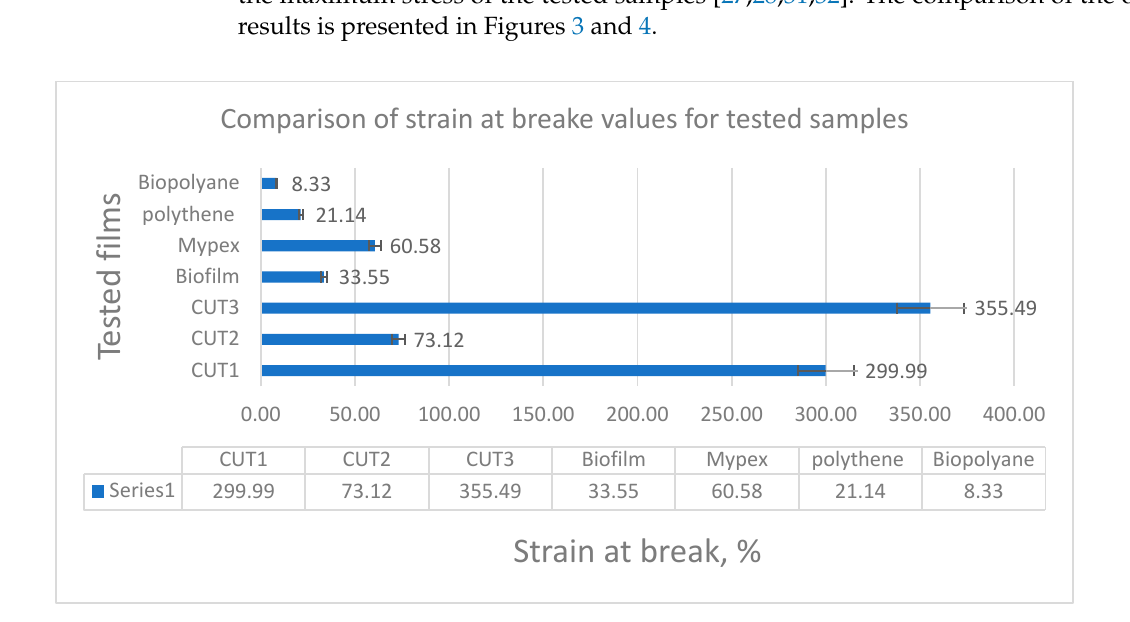
Figure 3. Comparison of the maximum strain at brake of the tested samples.